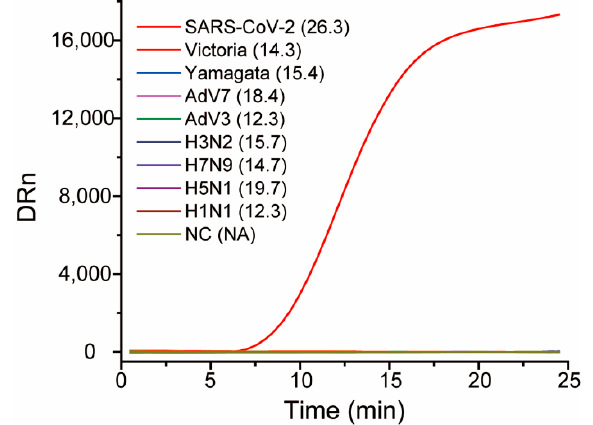
Figure 4. The typical amplification curves for specificity evaluation. The numbers in the